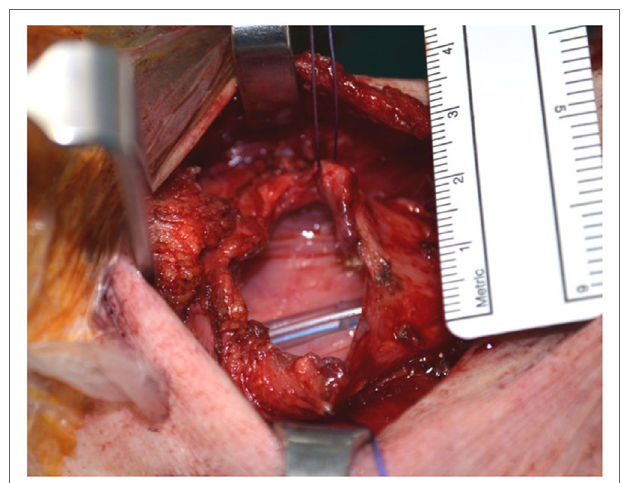
FigUre 6 | Small pharyngeal opening, about 5 cm that will be closed horizontally.